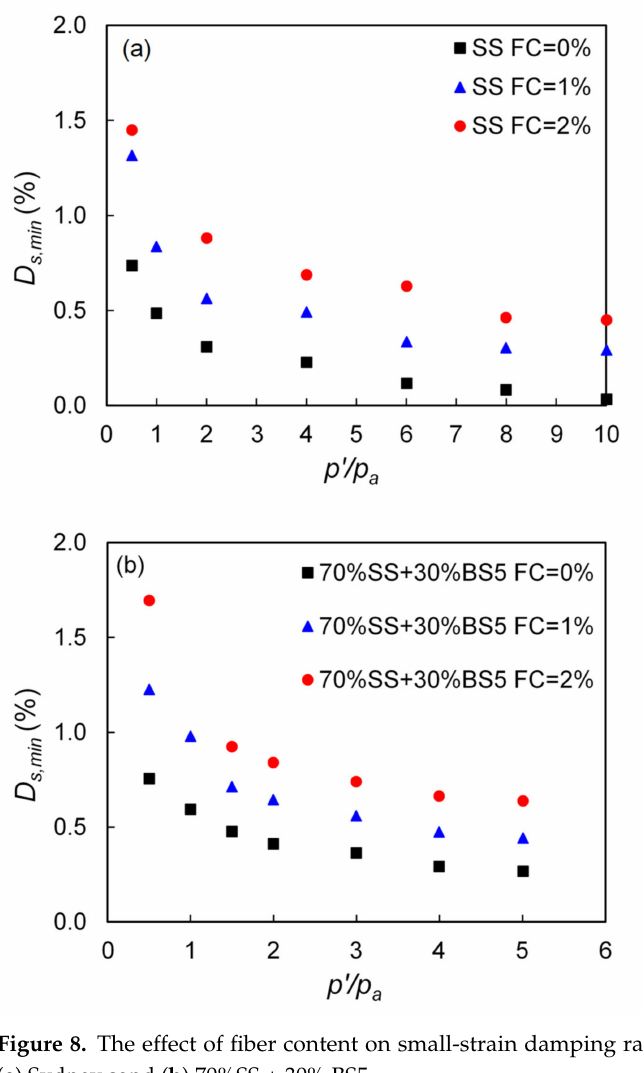
Figure 8. The effect of fiber content on small-strain damping ratio with two different host sands